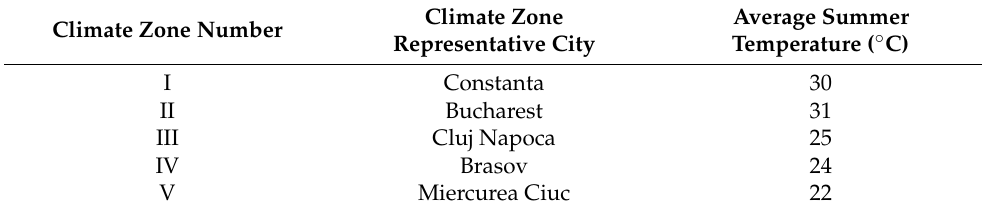
Table 2. Outdoor